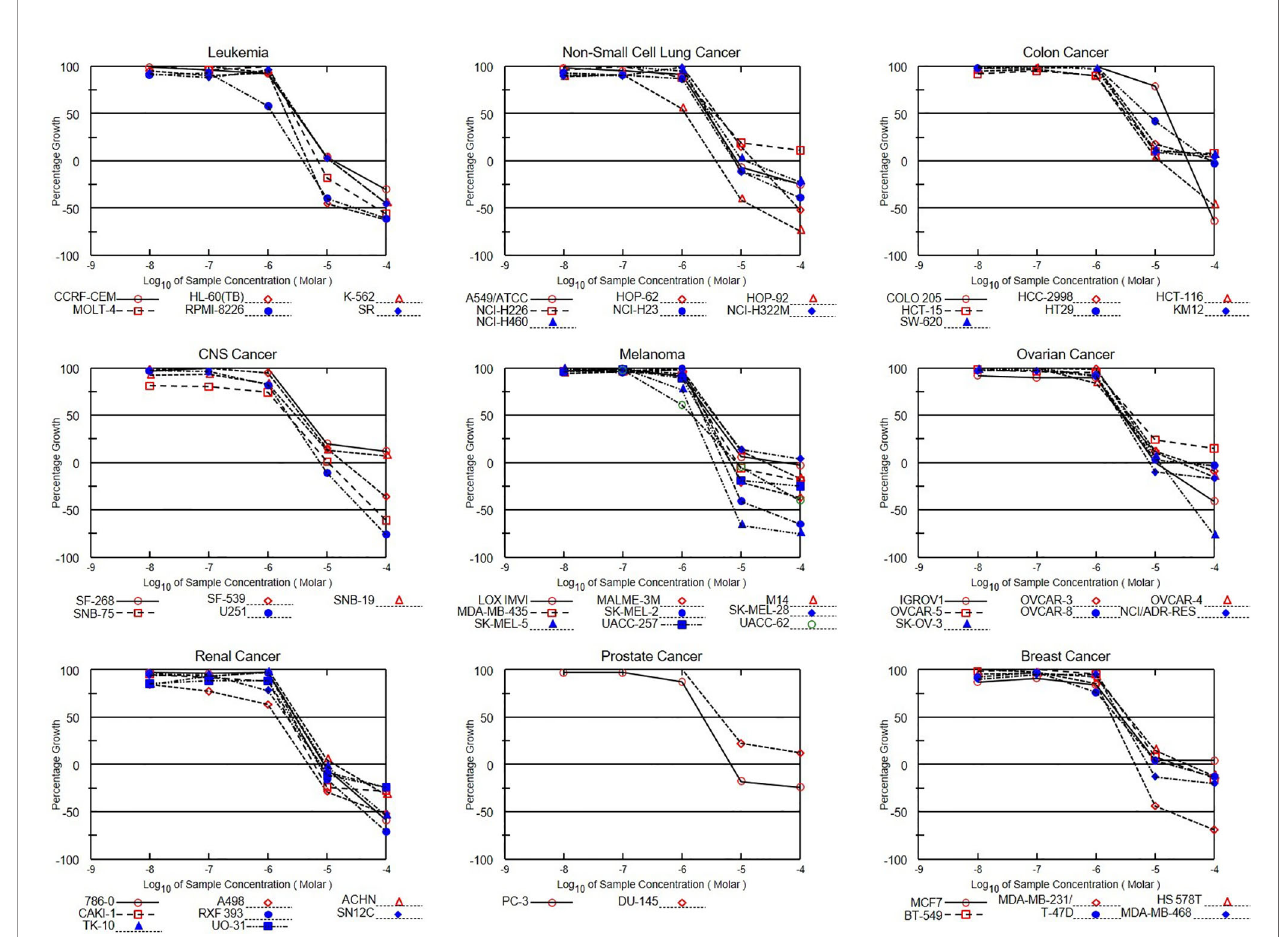
FIGURE 10 | Dose-response curves of NCI60 human cancer cell lines to NSC765598 treatment. Growth percentage value of 100 on the y-axis represents the growth of untreated cells, the 0 value represents no net growth, while − 100 represents complete death of